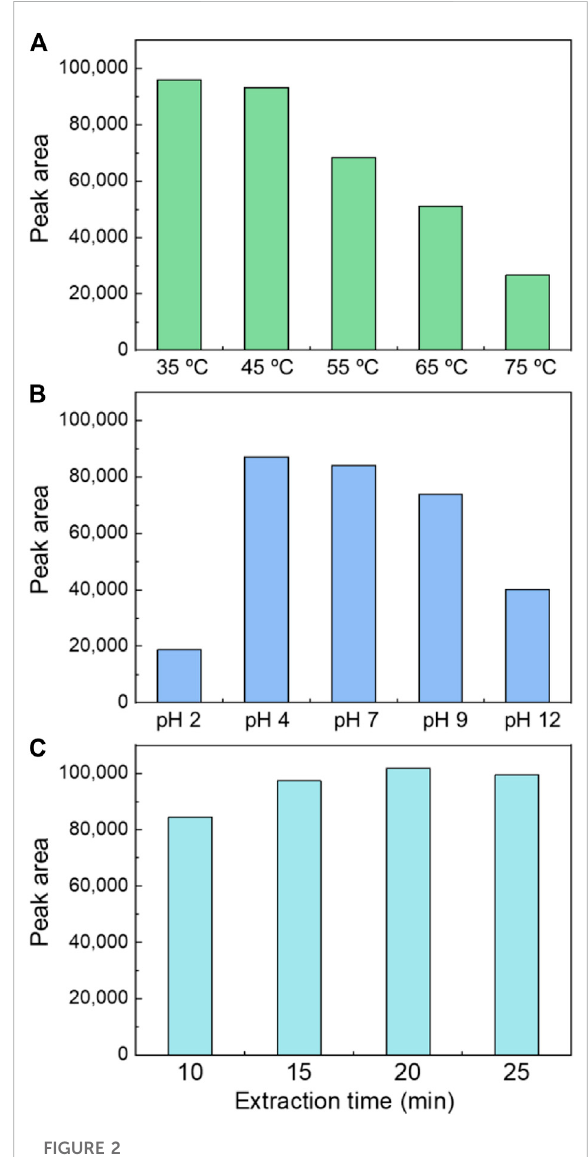
FIGURE 2 Optimizing the SPME extraction conditions for ECH detection. Impact of (A) Temperature, (B) pH, and (C) Extraction